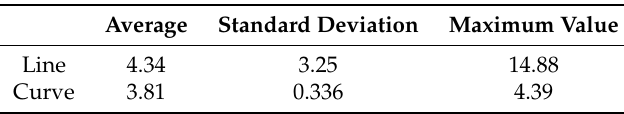
Table 2. Line/curve fitting error in